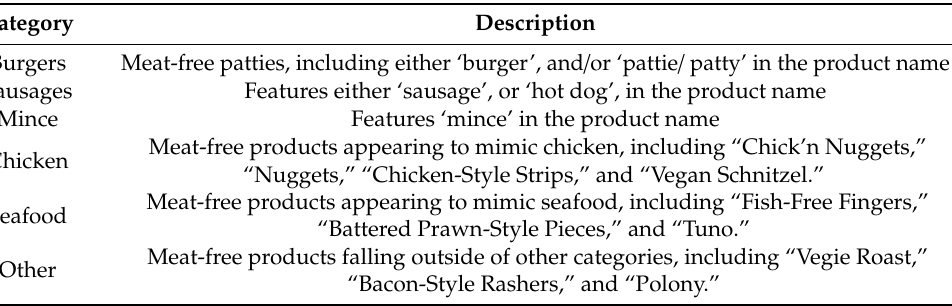
Table 1. Classification of